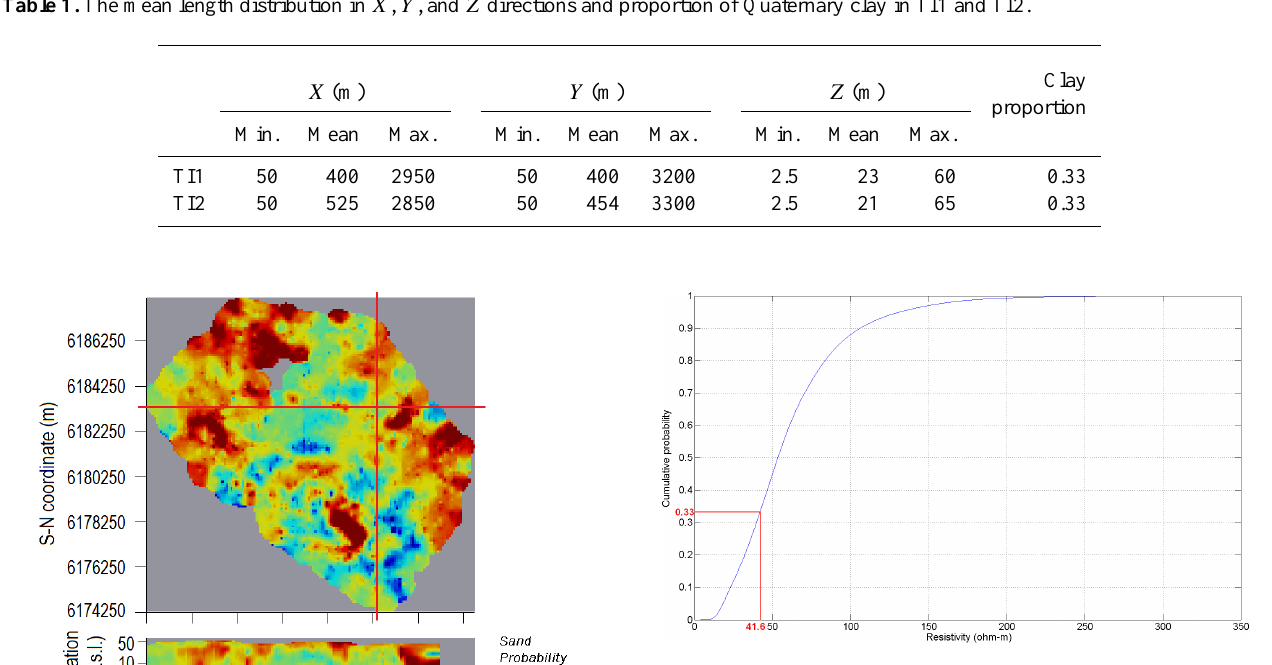
Table 1. The mean length distribution in X , Y , and Z directions and proportion of Quaternary clay in TI1 and TI2.